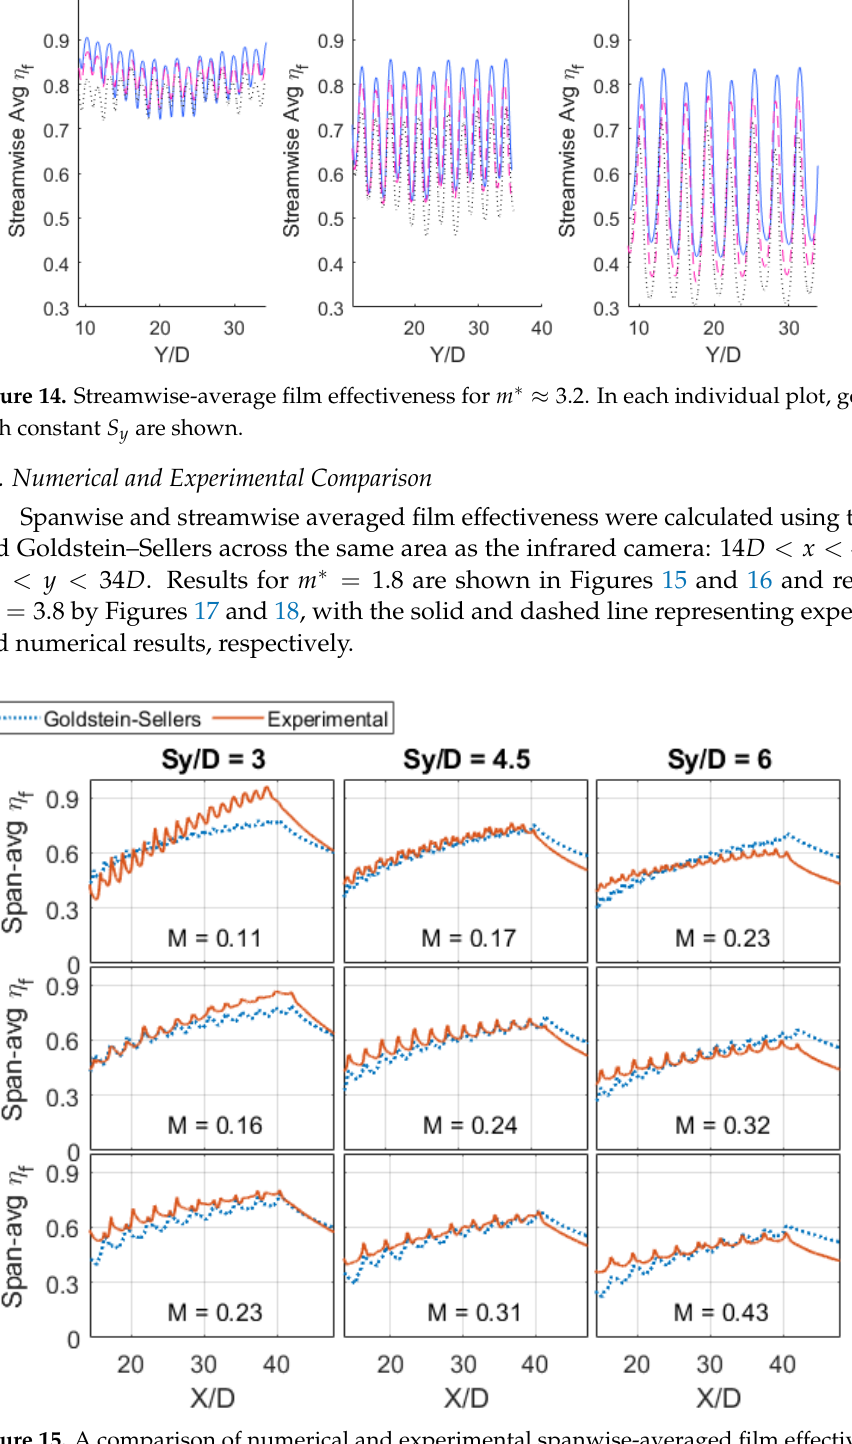
Figure 15. A comparison of numerical and experimental spanwise-averaged film effectiveness for m ∗ =